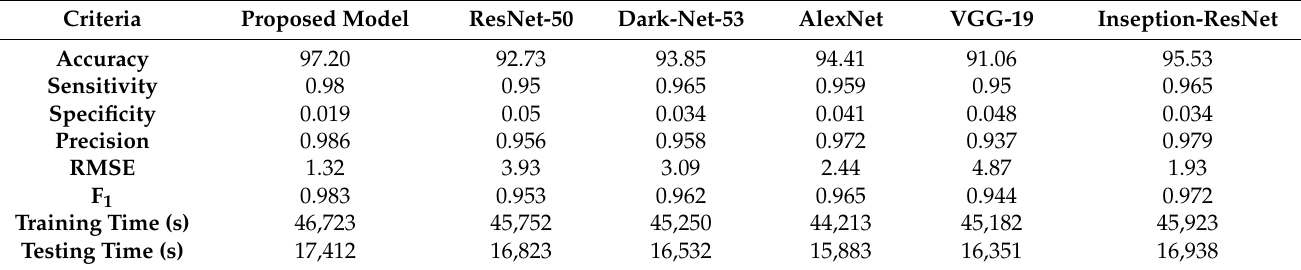
Table 1. Comparison of applied deep learning models’ performances with no data augmentation.